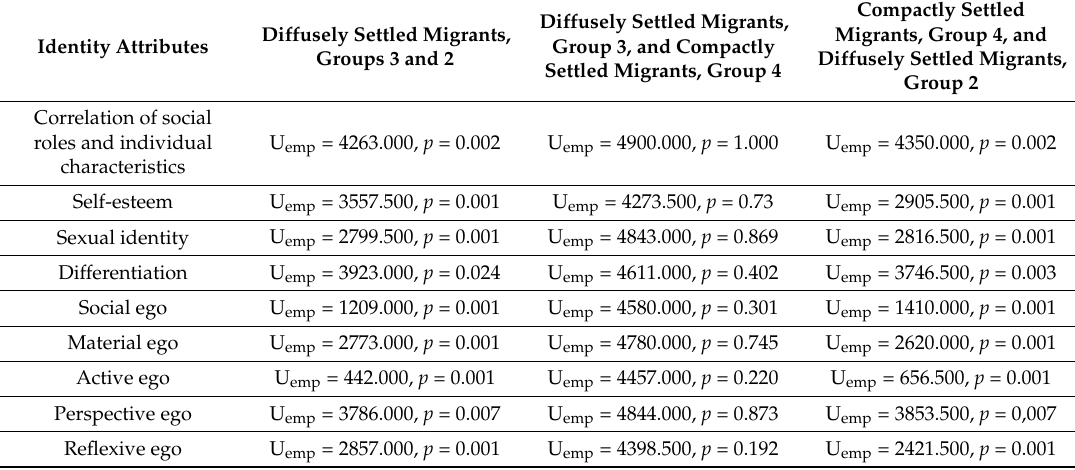
Table 3. Groups with significant differences compared to each other according to the Mann–Whitney test; other